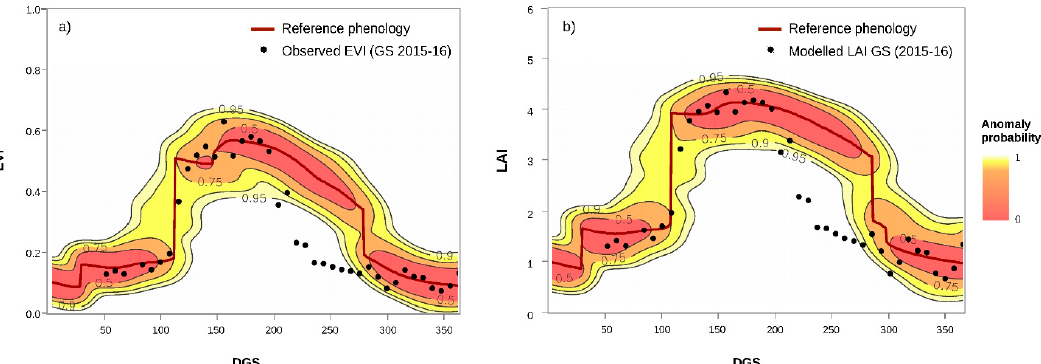
Figure 11. EVI ( a ) and LAI ( b ) reconstructed baseline phenology and observations during the O. amphimone outbreak for a single MODIS pixel.